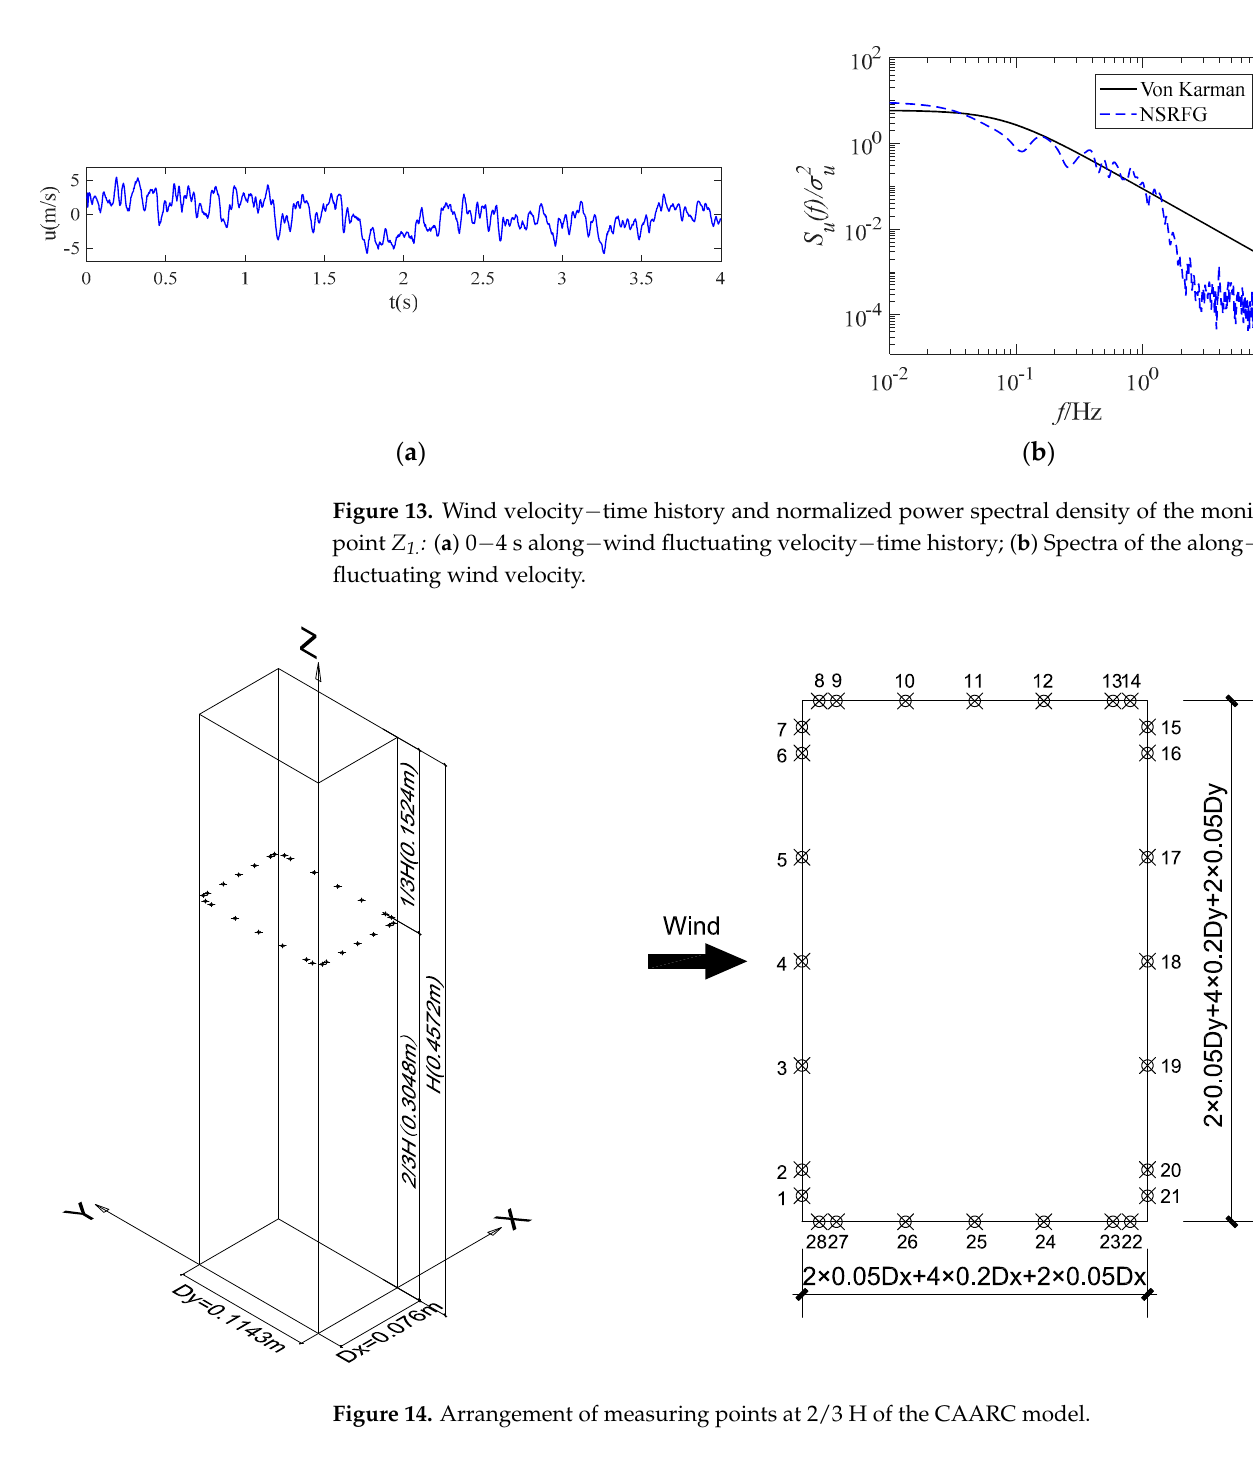
Figure 13. Wind velocity − time history and normalized power spectral density of the monitoring point Z 1. : ( a ) 0 − 4 s along − wind fluctuating velocity − time history; ( b ) Spectra of the along − wind fluc-